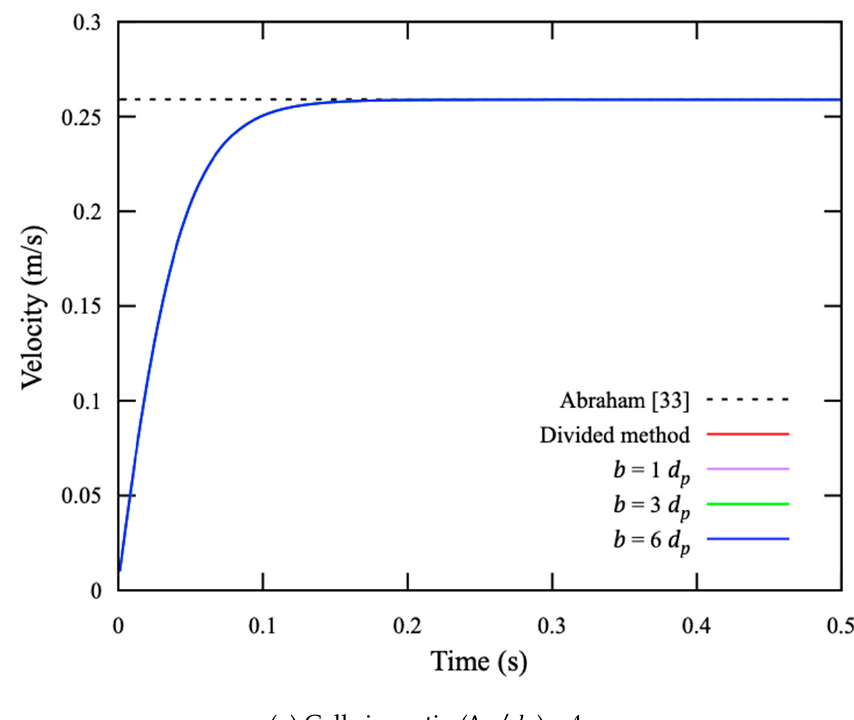
( a ) Cell size ratio ( ∆(cid:1876) (cid:1856) (cid:3043) ⁄ ) = 4. Figure 6.